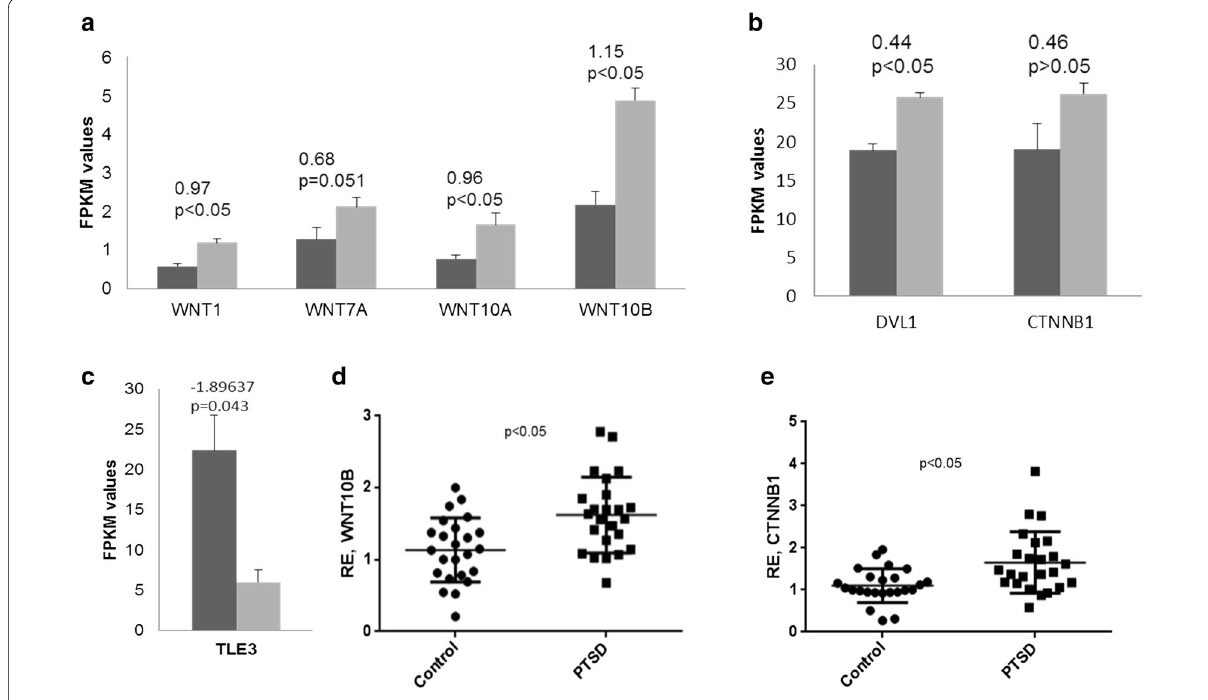
Fig. 1 RNA-seq analysis using PBMCs from PTSD and control participants. Five control and 5 PTSD patient samples each were included for the analysis using total RNA from PBMCs as described previously by us (Zhou et al. 2014). The expression levels of different genes including WNT ligands ( a ) and WNT signaling pathway ( b ), shown as FPKM values. Black and grey bars represent control and PTSD samples, respectively. The values above the bars indicate log2 fold change as obtained after RNAseq data analysis. c Expression level of TLE3 in control and PTSD patients. The transcript level of WNT10B and CTNNB1was validated by qRT-PCR in 24 control and PTSD samples each ( d , e ). The p values were derived from the RNA-seq data analysis tool ( a – c ) and Student’s t test ( d , e